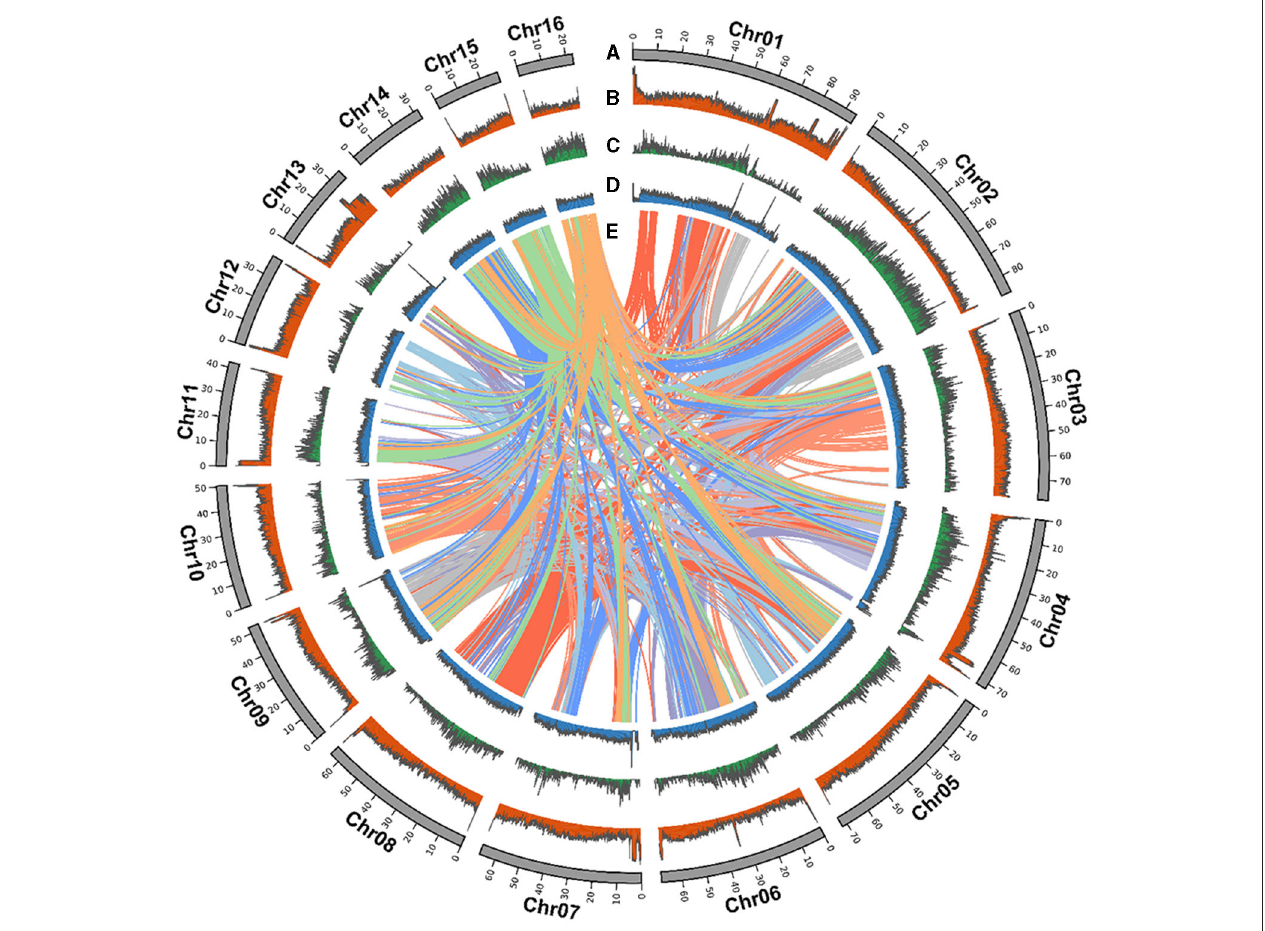
FIGURE 1 | Strobilanthes cusia chromosomal elements in global view. (A) Chromosome karyotype. (B) GC content. (C) Gene density. (D) DNA transposable elements (TEs). (E) Schematic presentation of the major inter-chromosomal relationships in the S. cusia genome.